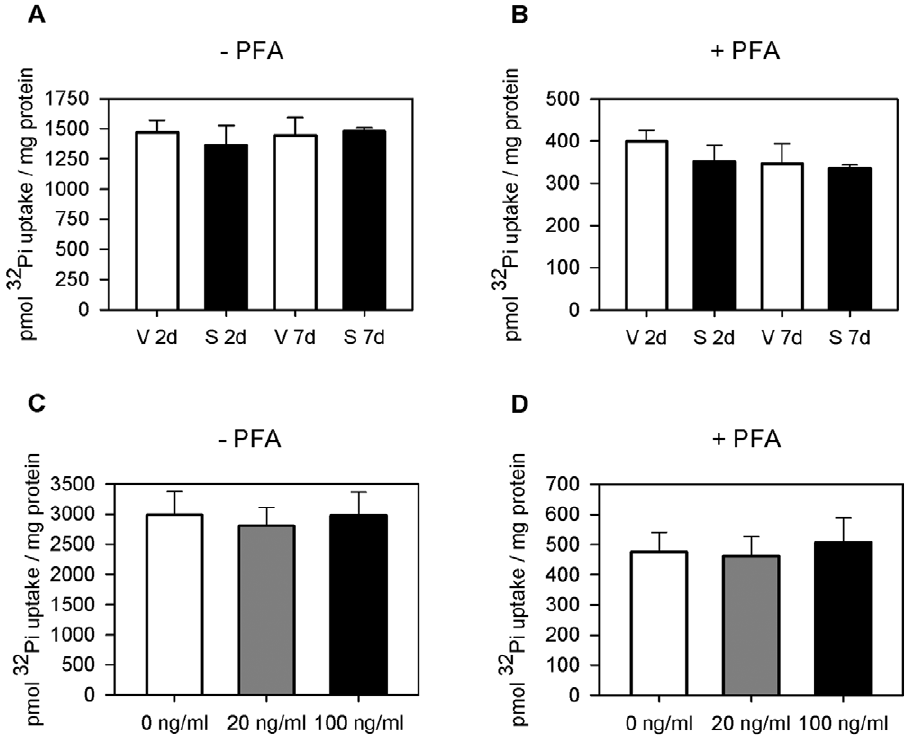
Figure 2. Sirolimus has no effect on apical renal phosphate transport. Effect of Sirolimus treatment for two and seven days on BBM sodium- dependent phosphate uptake in absence and presence of phosphonoformic acid (6 mM, PFA), an inhibitor of SLC34 phosphate cotransporter. Sirolimus did not alter 32 Pi-uptake in absence ( a ) or presence ( b ) of PFA after two and seven days of sirolimus treatment (n=6 each group). Incubation of BBMV from untreated rats with 20ng/ml and 100ng/ml sirolimus did not change Na + -dependent phosphate fluxes in the absence ( c ) or presence ( d ) of PFA.